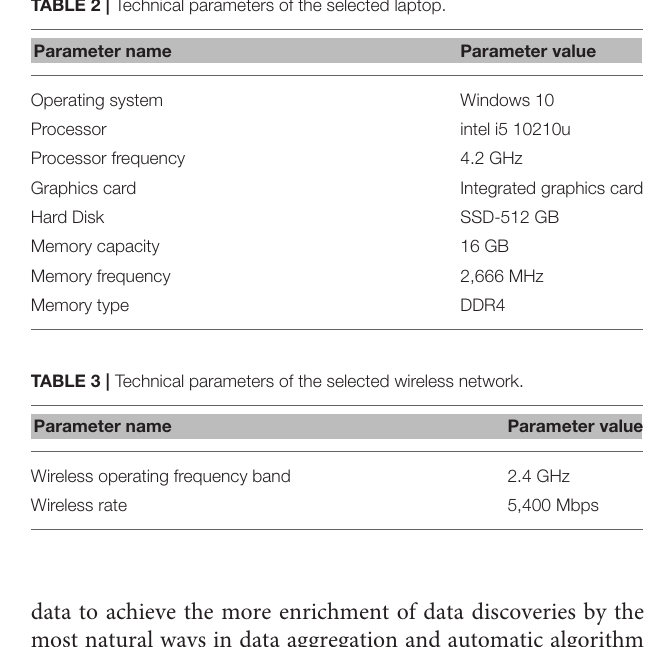
TABLE 2 | Technical parameters of the selected laptop.